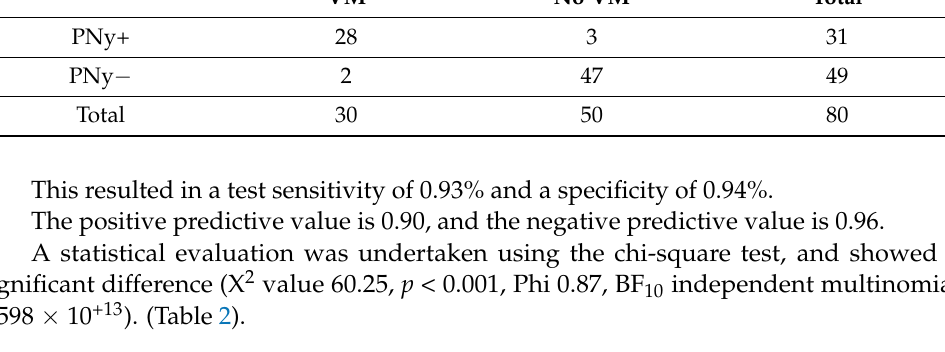
Table 2. Bayesian Contingency Tables. Pny: pupillary